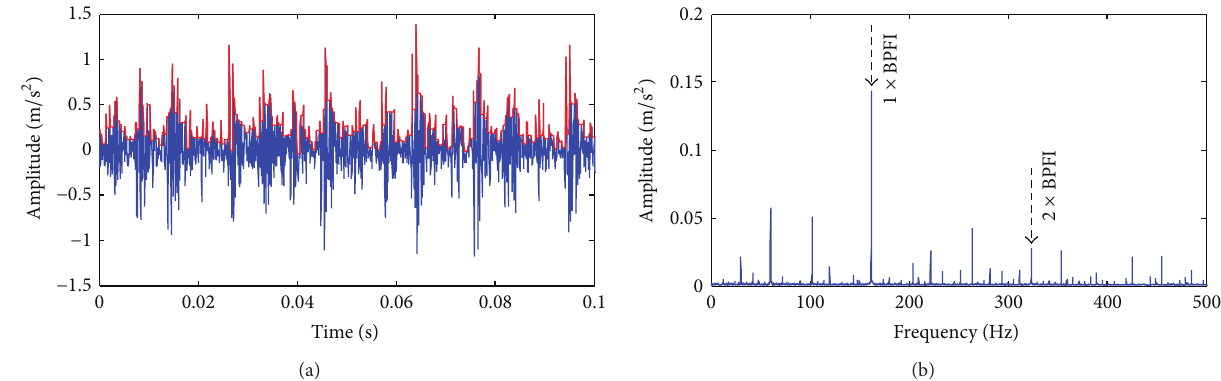
Figure 7: (a) Results of morphological operation closing; (b) frequency spectrum of (a).